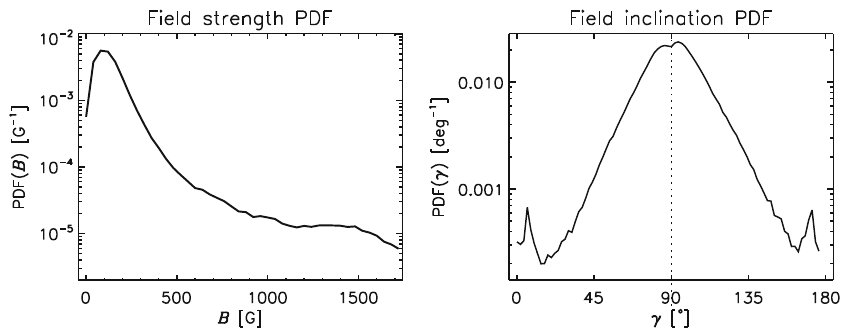
Fig. 30 Magnetic field strength (left) and inclination (right) probability density functions for IN regions resulting from a ME inversion of Hinode/SP data with a noise level of 3 × 10 − 4 I QS . Only pixels whose Stokes profile amplitudes exceed a polarization threshold of 4.5 times the noise level were included in the analysis. Inclinations are measured from the local vertical. Image reproduced with permission from Orozco Suárez and Bellot Rubio (2012), copyright by